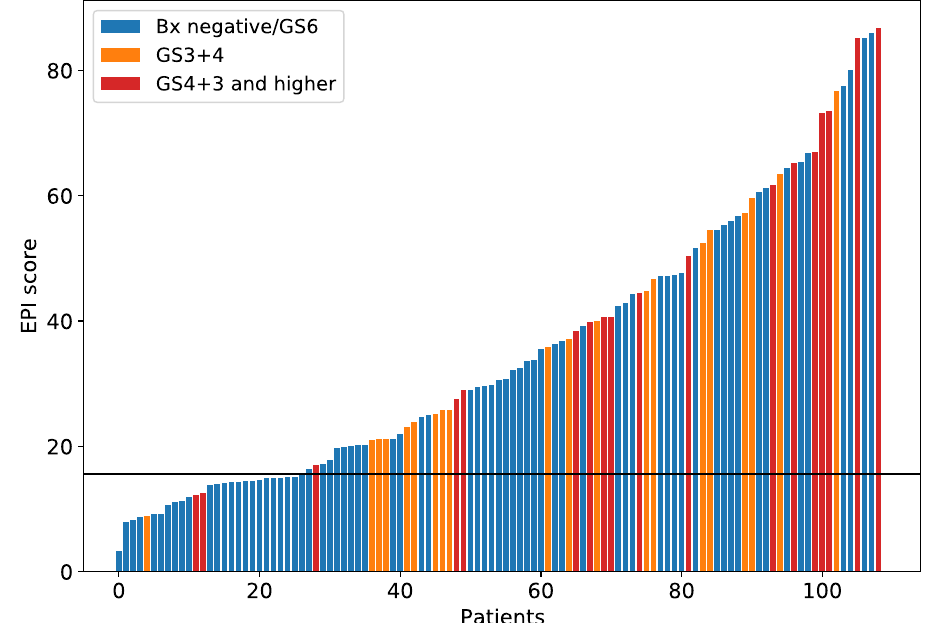
Figure 1. Waterfall plot of all individual subjects in the study, ranked by EPI score and colored by biopsy pathology outcome. The black horizontal line represents the 15.6 cut-point.